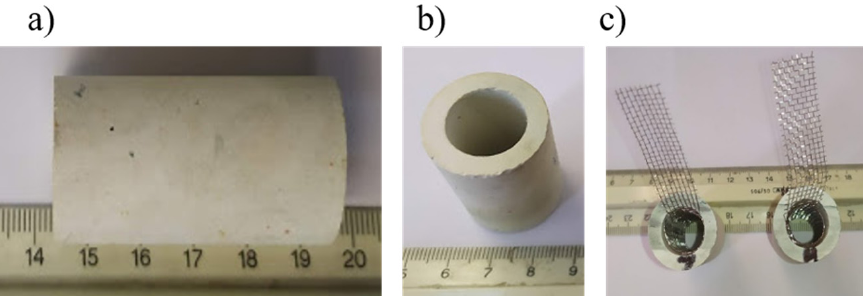
Figure 2. ( a ) Horizontal image and ( b ) vertical image of mullite tubes prior to the electrode preparation, ( c ) mullite tubes internally coated with catalytic paste and stainless steel mesh.